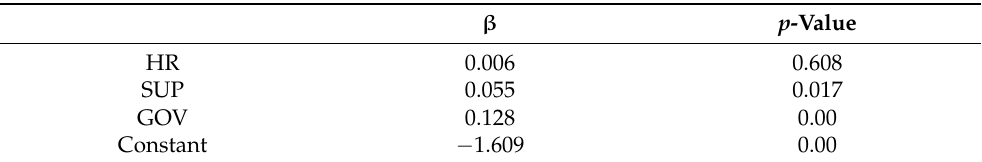
Table 9. Logistic regression results for COM1 (implementation of innovation) independent variable.